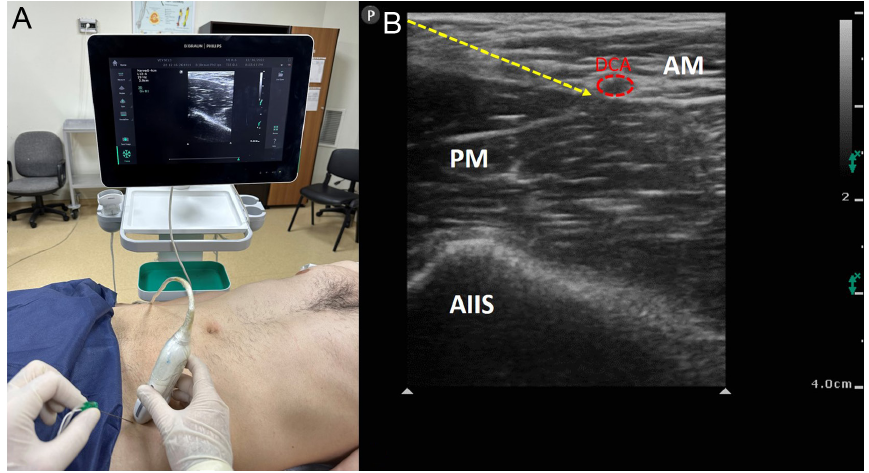
Figure 10. A, B. (A) Patient and ultrasound probe position for suprainguinal fascia iliaca block procedure. (B) Sonographic anatomy of the block. AIIS, anterior inferior iliac spine; AM, abdominal muscles; DCA, deep circumflex iliac artery; FA, femoral artery; PM, psoas muscle; yellow arrow,